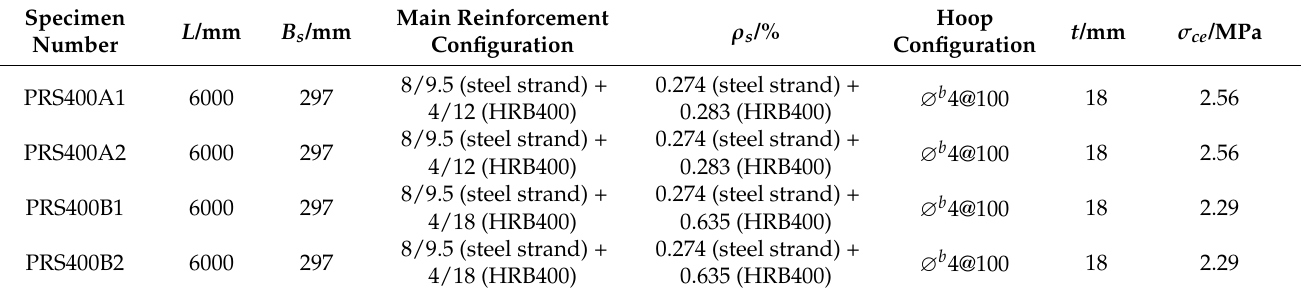
Figure 1. Main dimensions and reinforcement diagram of the PRS. Table 1. Design parameters of the PRS.